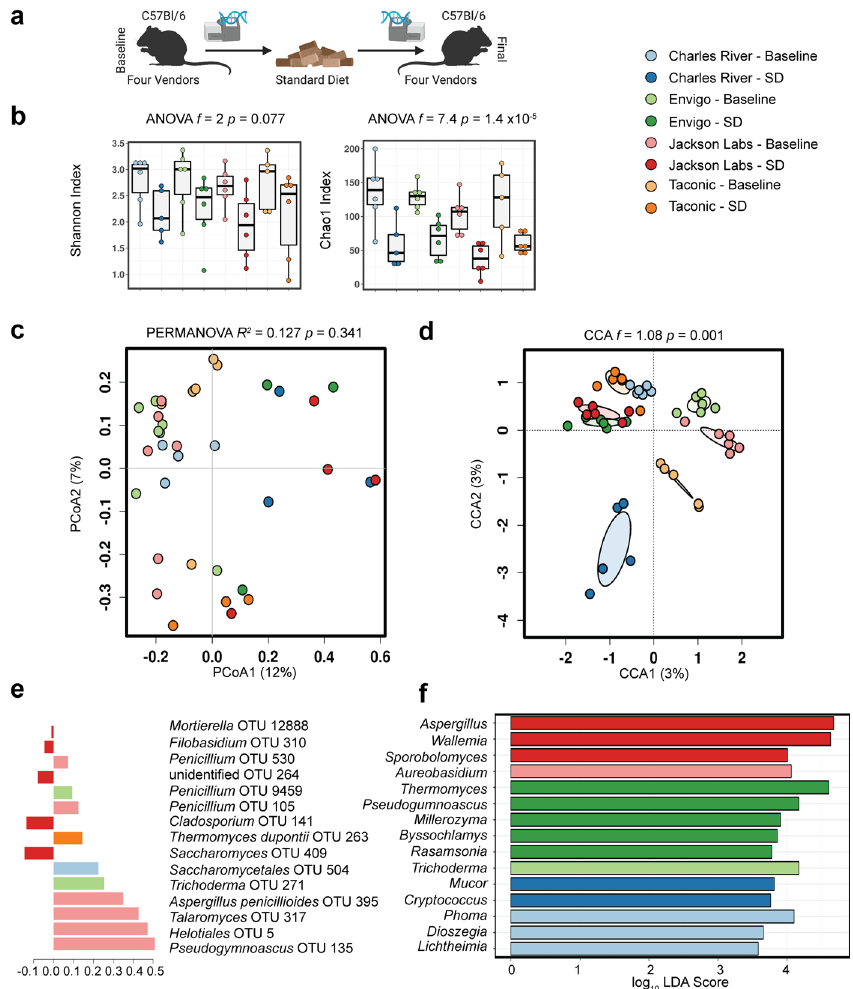
Fig. 1 Gut fungal communities cluster by vendor, age, and dietary exposure. a Experimental schematic. b Compared to healthy mice exposed to a standardized chow diet for 8 weeks, baseline community diversity is higher in mice upon delivery from vendors. While gut fungal communities remained distinctly clustered by vendor, exposure to a standardized chow diet for 8 weeks exerted a convergent effect on community composition ( c , d Bray – Curtis dissimilarity distance). Supervised partial least squares discriminant analysis ( e ) and linear discriminant analysis of effect size ( f ) con fi rm key operational taxonomic units and genera driving differences in community composition. Hypothesis testing was performed using ANOVA ( b ), PERMANOVA ( c ), and CCA ( d ). CCA canonical correspondence analysis, OTUs operational taxonomic units, SD standard diet, PERMANOVA permutational multivariate ANOVA, PCoA principal coordinates analysis. Schematic created using BioRender.com.